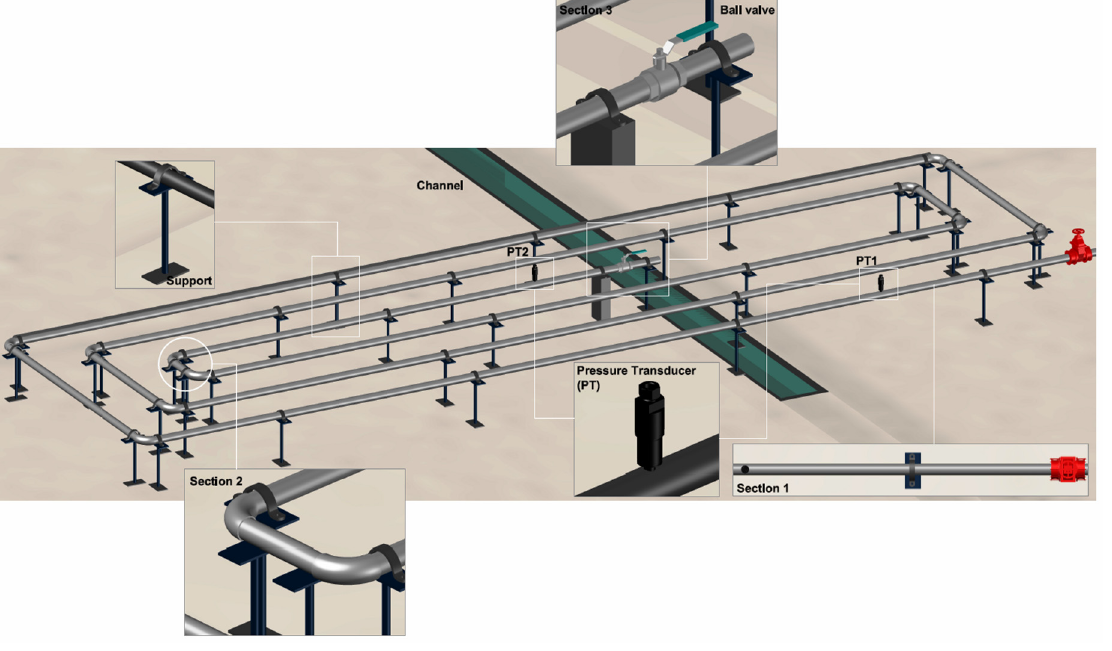
Figure 1. Scheme of the laboratory